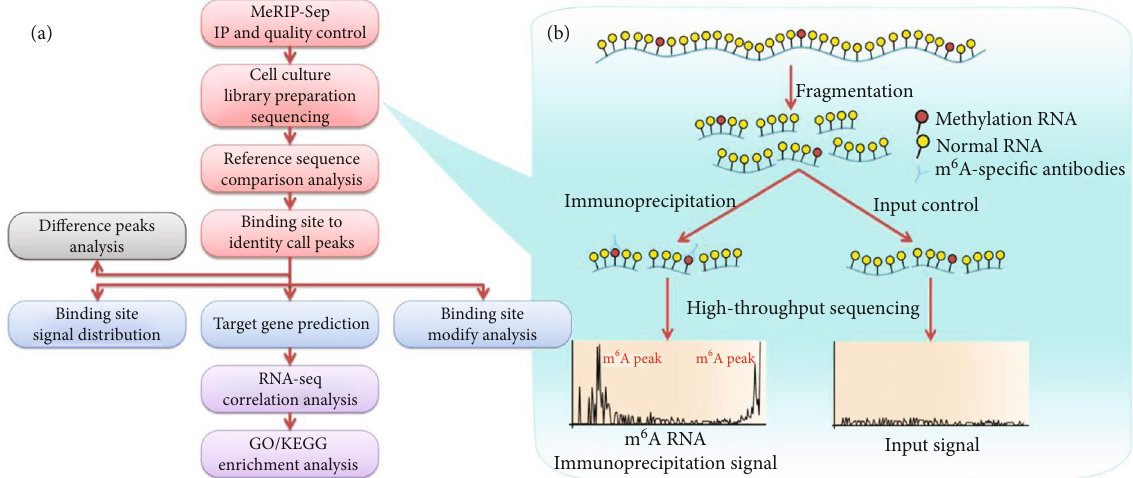
Figure 1: MeRIP-Sep and peak calling analysis. (a) As shown in the fl owchart, each group comprised two types of sample RNAs, that is, immunoprecipitation (IP) samples and input control samples, which were fragmented into ~ 100 nucleotides and immunoprecipitated with m 6 A-speci fi c antibodies. (b) Following the library construction, high-throughput sequencing, and bioinformatics analysis, the location of m 6 A in the whole transcriptome could be provided. Peak calling referred to the use of certain statistical methods to detect the area (called peak) where the reads were remarkably enriched in RNA, as a candidate for m 6 A modi fi cation sites. After the peak was obtained, peak sequence motif and peak annotation analyses were performed in the peak to further explore the direction of